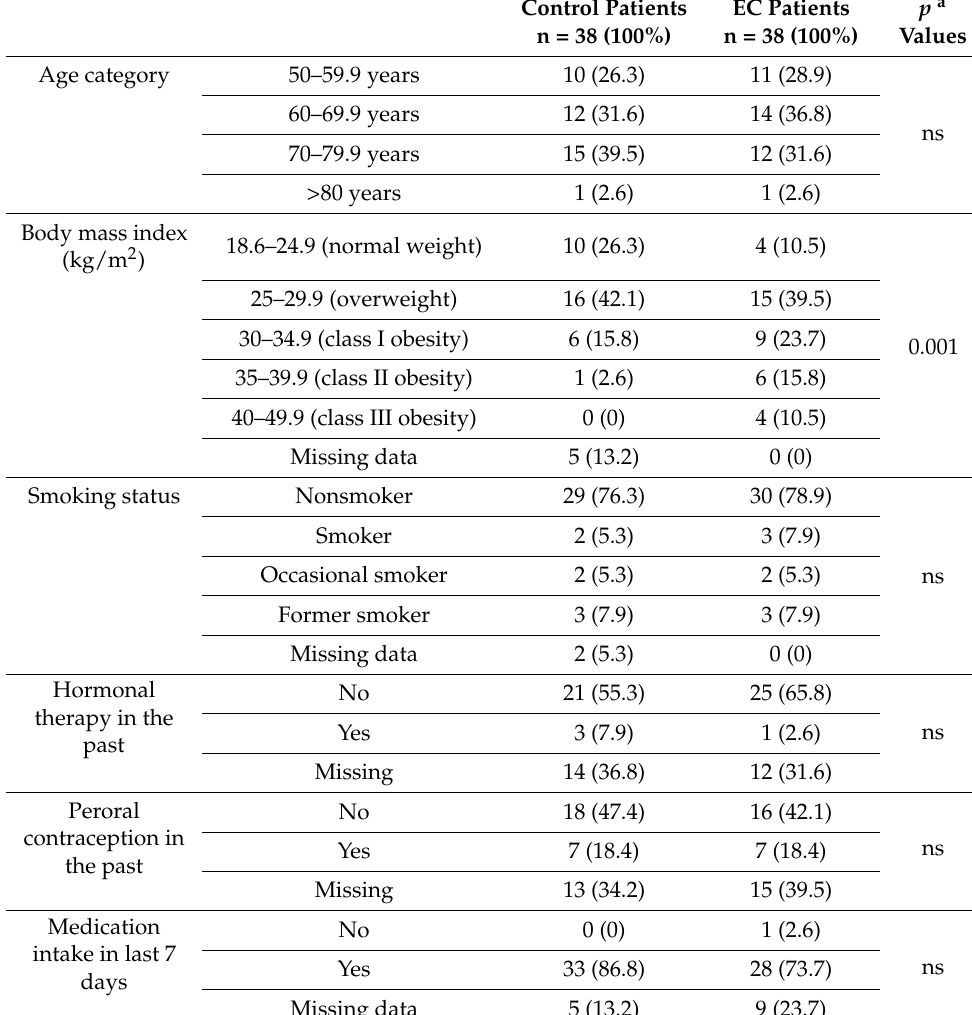
Table 1. Detailed clinical characteristics of the study